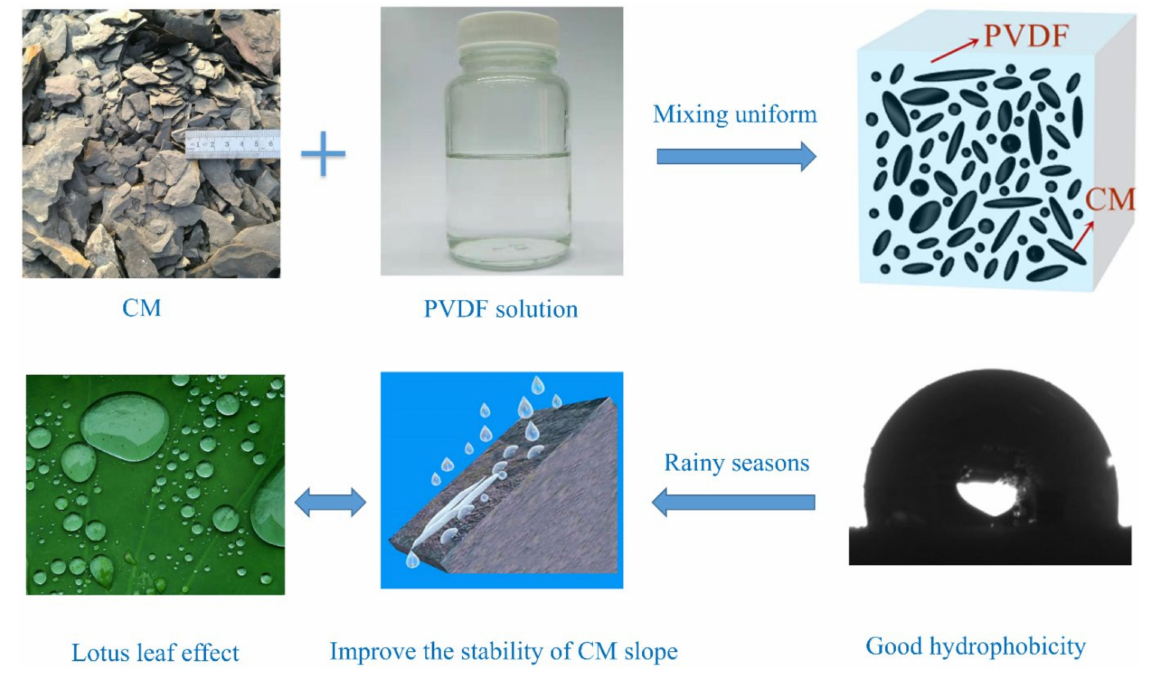
Figure 3. Schematic diagram of hydrophobic material (i.e., PVDF)-modified